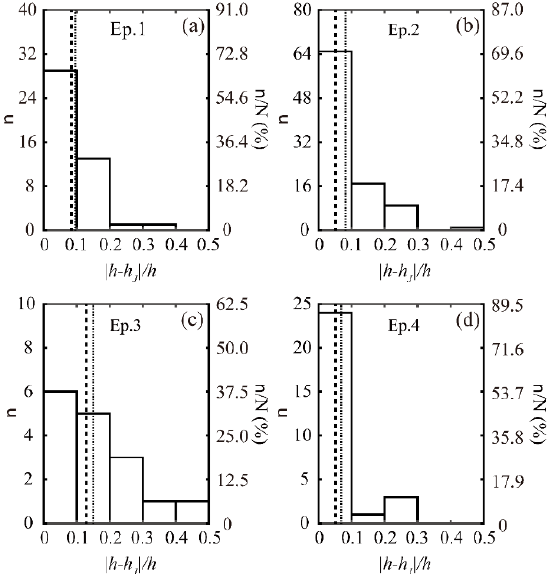
Figure 9. Histograms of the normalized absolute errors of the difference between h and h J . All data for the four episodes, ( a ) Ep. 1, ( b ) Ep. 2, ( c ) Ep. 3, and ( d ) Ep. 4, are shown Table S3.